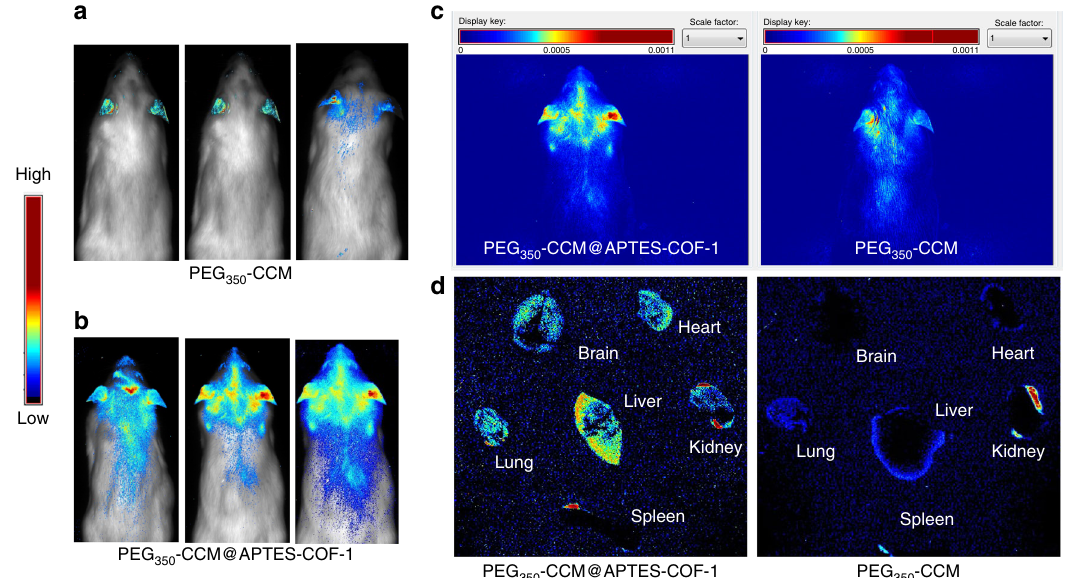
Fig. 8 In vivo fl uorescence imaging for brain tumor targeting and biodistribution. a, b In vivo fl uorescence imaging of brains collected from ICR mice treated with PEG 350 -CCM@APTES-COF-1 (up) or PEG 350 -CCM (down) at 4 h post injection. c In vivo fl uorescence imaging for brain tumor targeting and biodistribution under the same conditions. d Ex vivo fl uorescence imaging of organs from ICR mice treated with PEG 350 -CCM@APTES-COF-1 or PEG 350 - CCM. The organs from top to bottom are as follows: brain, heart, liver, lung, kidney, and